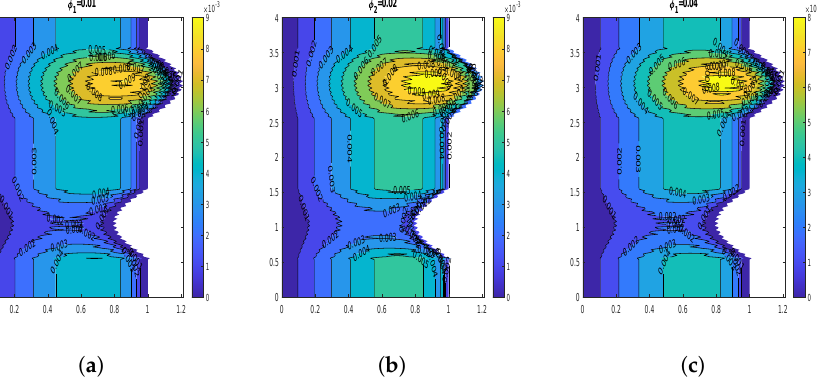
Figure 10. Blood flow patterns for volume fraction of CuO-nanoparticles ( a ) φ 1 = 0.01, ( b ) φ 1 = 0.02, ( c ) φ 1 =